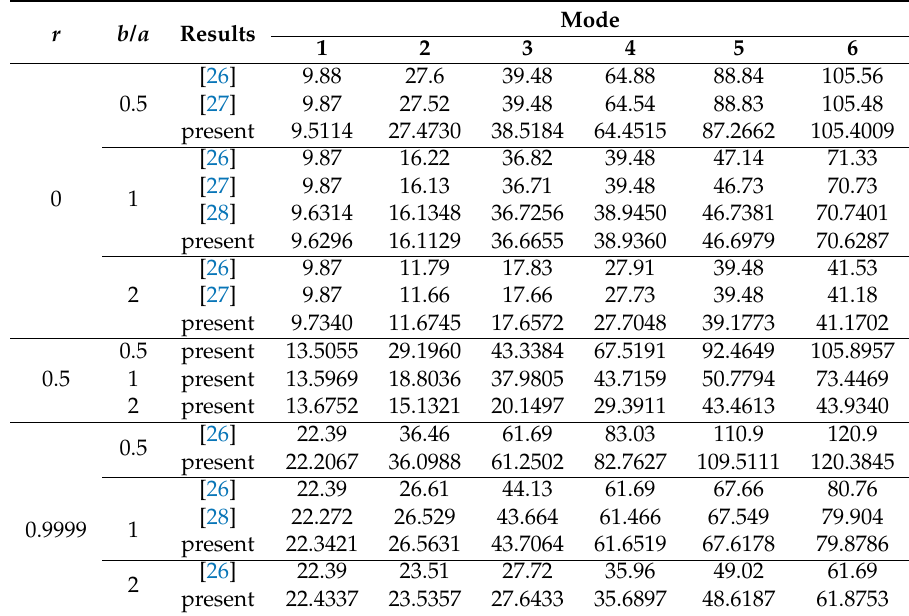
Table 1. First six frequency parameters Ω = ω a 2 rotational fixity factors ( ν =